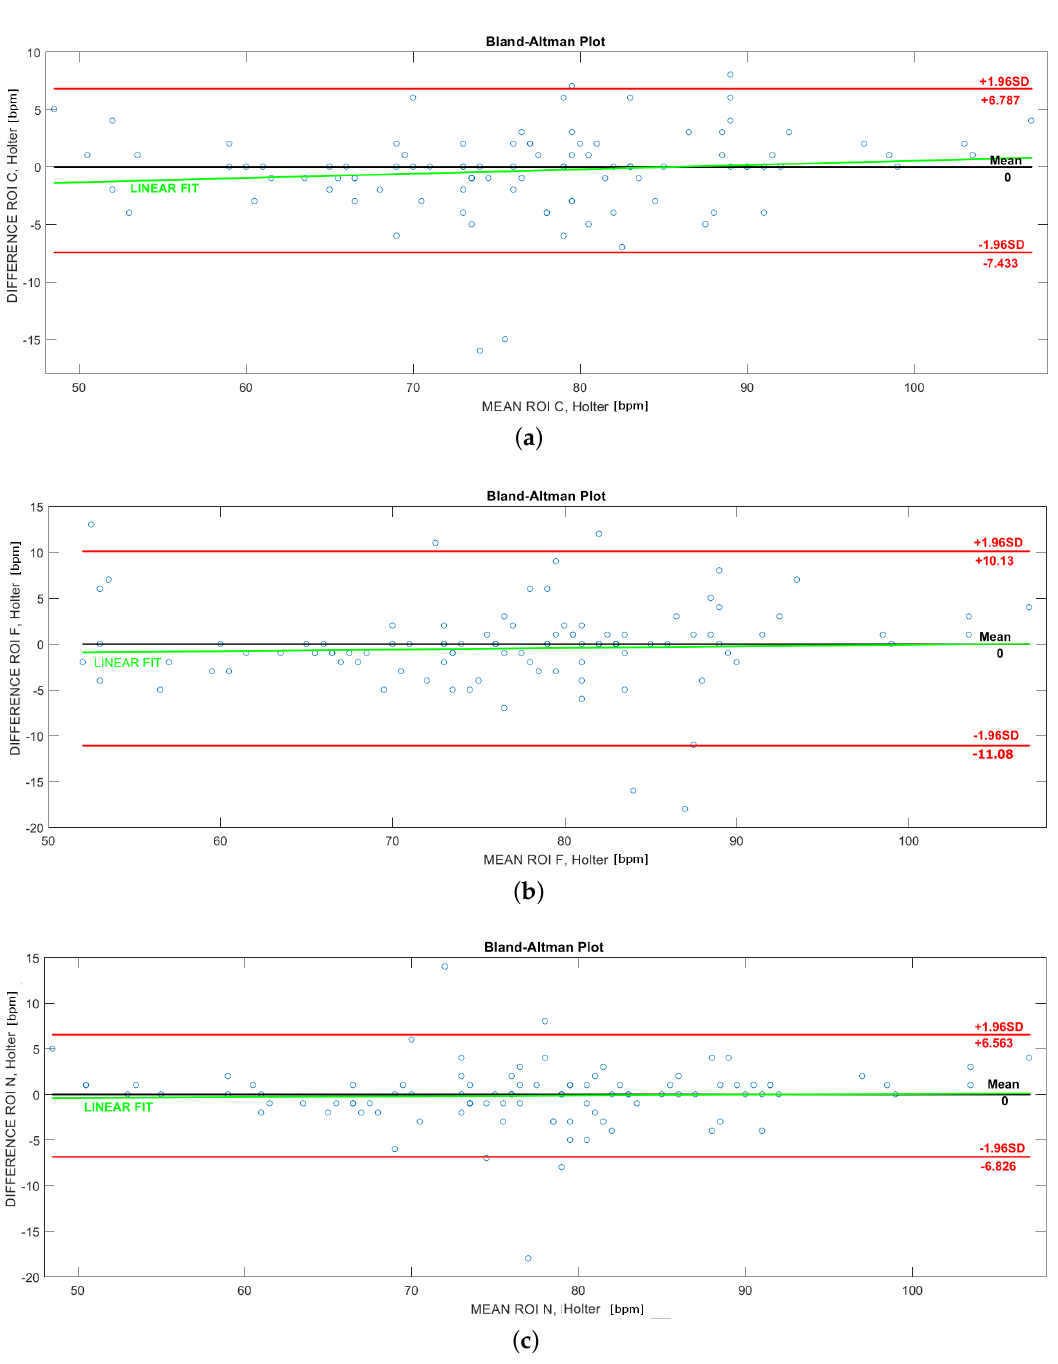
Figure 7. Bland–Altman plot, correlation between HR values extracted by the Holter and through the proposed method in: ( a ) ROI C; ( b ) ROI F; ( c ) ROI